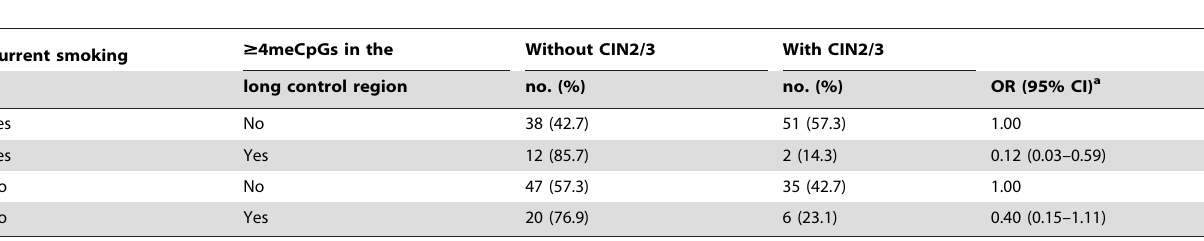
Table 3. Odds ratios and 95% confidence intervals for the association of CIN2/3 with $ 4meCpGs in the 3 9 end of the long control region, stratified by current smoking